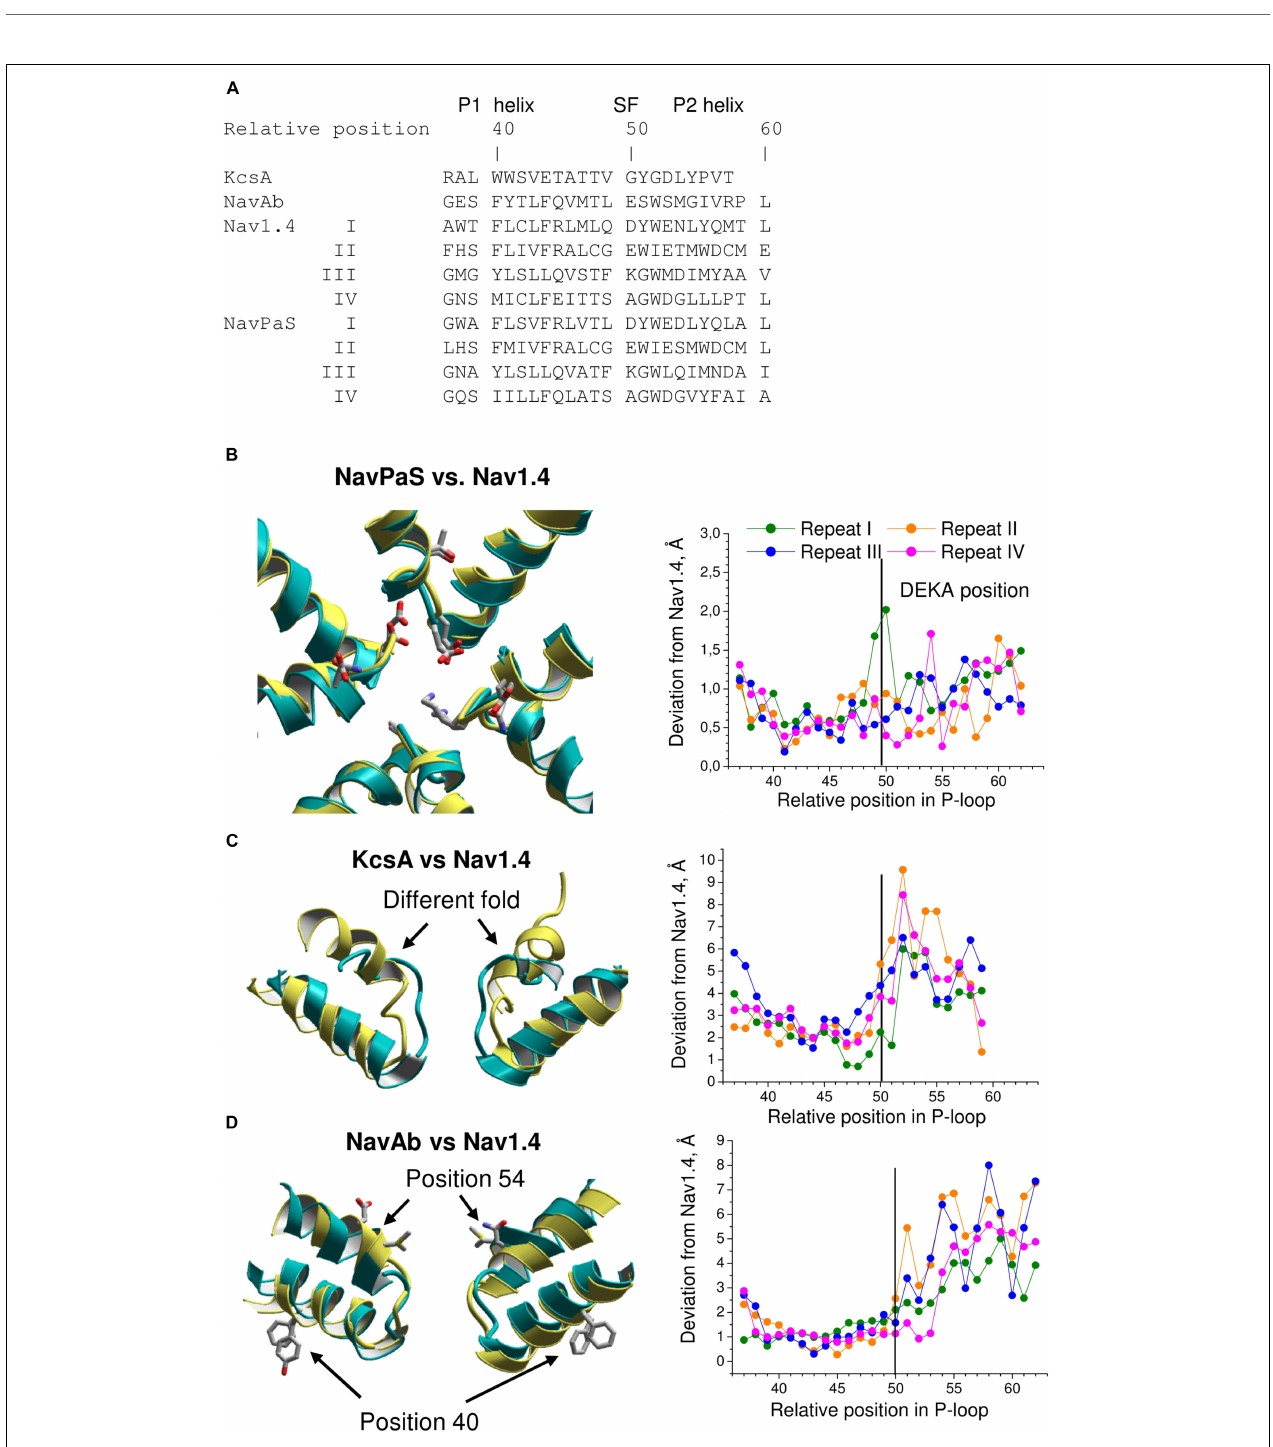
FIGURE 5 | Comparison of P-loops in Nav1.4, NavPaS, KcsA, NavAb. (A) Straightforward sequence alignment of P-loops. In the NavPaS and Nav1.4 sequences the repeat numbers are indicated by roman numerals. The top row shows relative positions of residues in the aligned sequences; position 50 is assigned to the selectivity-filter DEKA residues. Comparison of NavPaS (B) , KcsA (C) , and NavAb (D) structures with Nav1.4. The structures are 3D aligned by minimizing RMS deviations of alpha carbons in the P1 helices from matching atoms in Nav1.4 according to the sequence alignment shown in (A) . Left panels show 3D aligned structures with Nav1.4 in yellow. Right panels are plots of deviations of alpha carbons from matching atoms in Nav1.4. (B) NavPaS is similar to Nav1.4 and most deviations are less than 1.5 Å. The selectivity filter residues and the outer carboxylates are shown as sticks in the superimposed structures. (C) KcsA significantly deviates from Nav1.4 in the outer pore region where sodium and potassium channels have different folding. (D) NavAb and Nav1.4 have similar P1-helices, but large deviations are seen in the P2 helices where amino acids in matching positions (according to the straightforward sequence alignment) have different orientations in the 3D-aligned